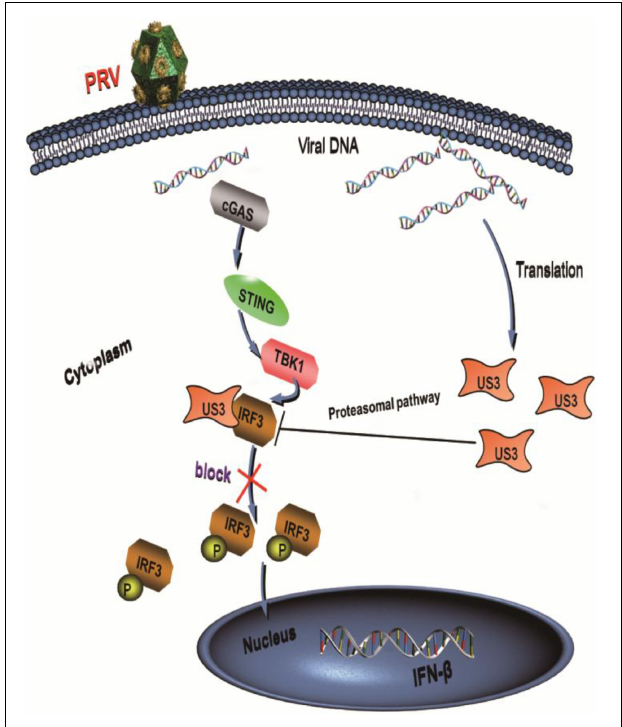
FIGURE 7 | PRV protein kinase US3 interacts with IRF3 and degrades IRF3 protein expression through proteasome pathway. Additionally, US3